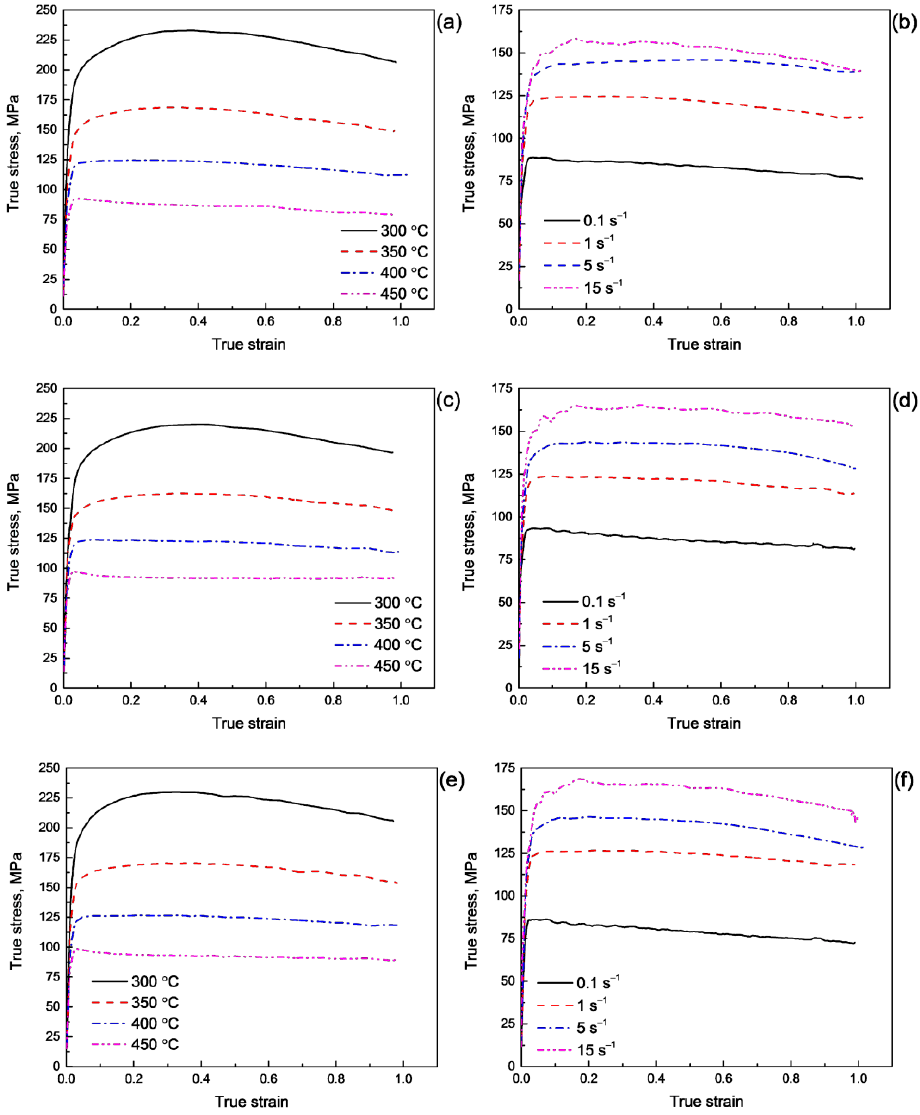
Figure 2. True stress true strain curves of the alloys 0.05Sc ( a , b ), 0.1Sc ( c , d ) and 0.15Sc ( e , f ) at different temperatures and a strain rate of 1 s − 1 ( a , c , e ), and different strain rates and a temperature of 400 °C ( b , d , f ).